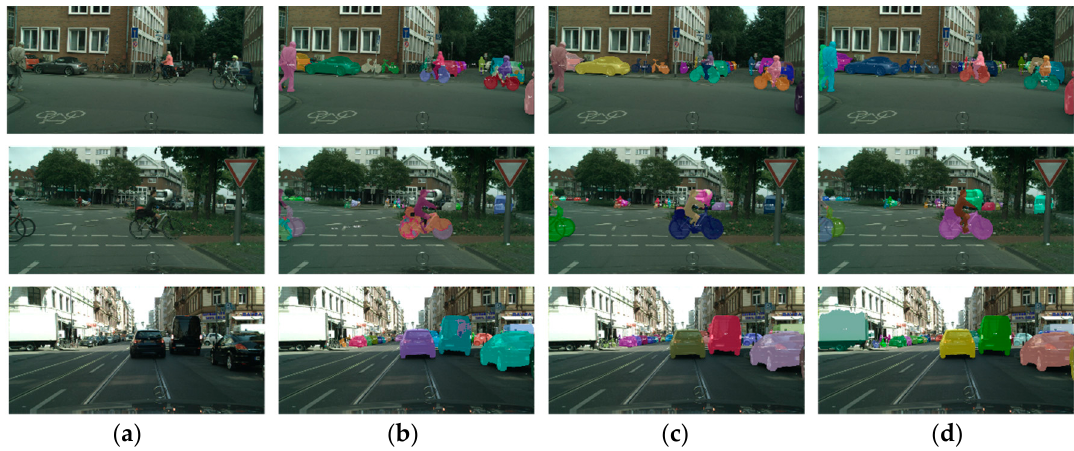
Figure 6. Comparison of instance segmentation results of different methods. ( a ) Original images; ( b ) the instance segmentation results of baseline; ( c ) the instance segmentation results of baseline with CBAM and CTAM; ( d ) the instance segmentation results of baseline with AFPM.